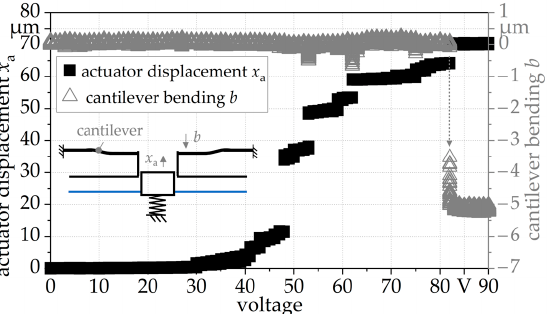
Figure 10. Displacement of the bending plate actuator and bending of the cantilever depending on the applied voltage, for the actuator of step 5 of system